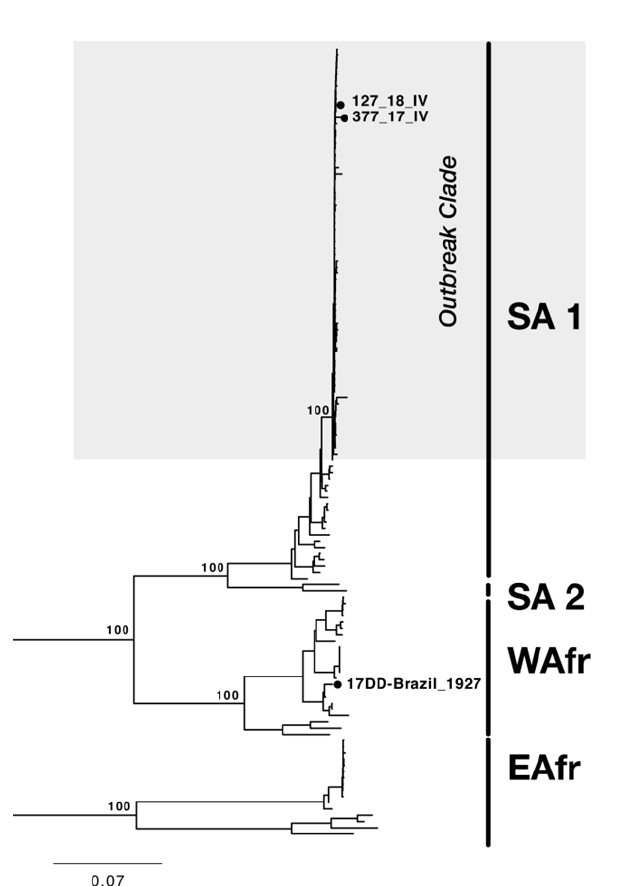
Figure 2. Maximum likelihood phylogeny obtained using two novel complete Yellow fever virus sequences plus 126 YFV reference sequences from each different genotype (South American I; South American II; West African; East African). ML showing the two newly genomes belongs to South American I (SA1) genotype. SA2, WAfr, and EAfr indicate the South America II, West Africa, and East Africa genotypes, respectively. The scale bar is in units of substitutions per site (s/s). Node labels indicate bootstrap support values.17DD, the vaccine strain used in